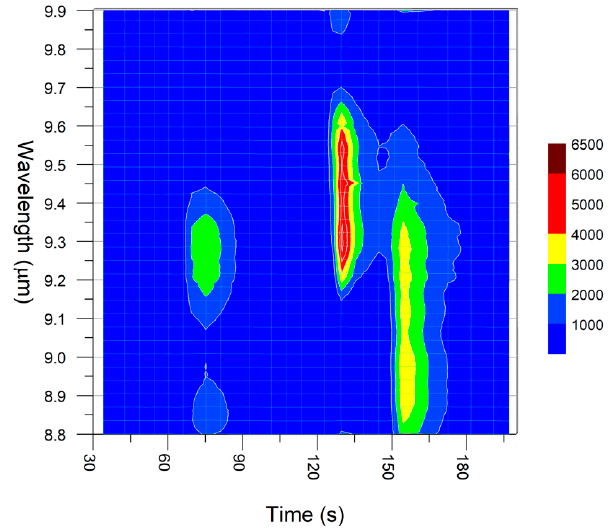
Figure 12. Color plot of all spectra acquired for the mixture of propanol, DMMP and DPGME.